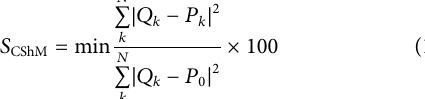
Figure 4A. Absorption bands are observed at 388, 369, and 359 nm for [Gd 2 (hfa) 6 (PDDPO) 2 ]. Their absorption bands are assigned to (0, 0), (0, 1), and (0, 2) π - π * transitions of the PDDPO ligands, respectively